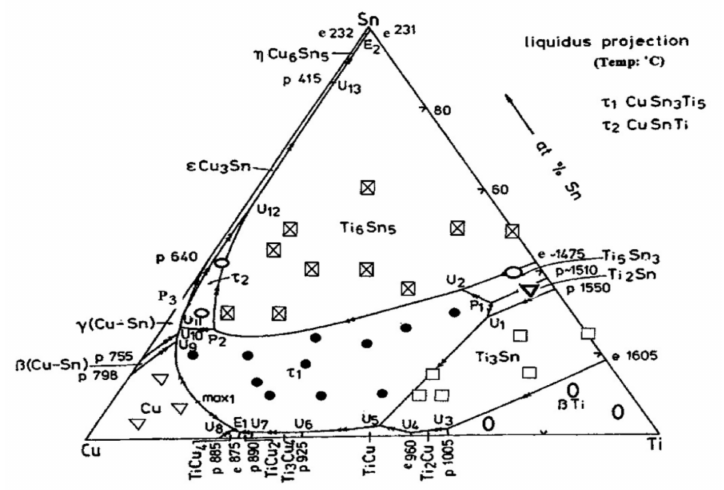
Figure 30. Liquidus surface projection in Cu-Sn-Ti ternary system